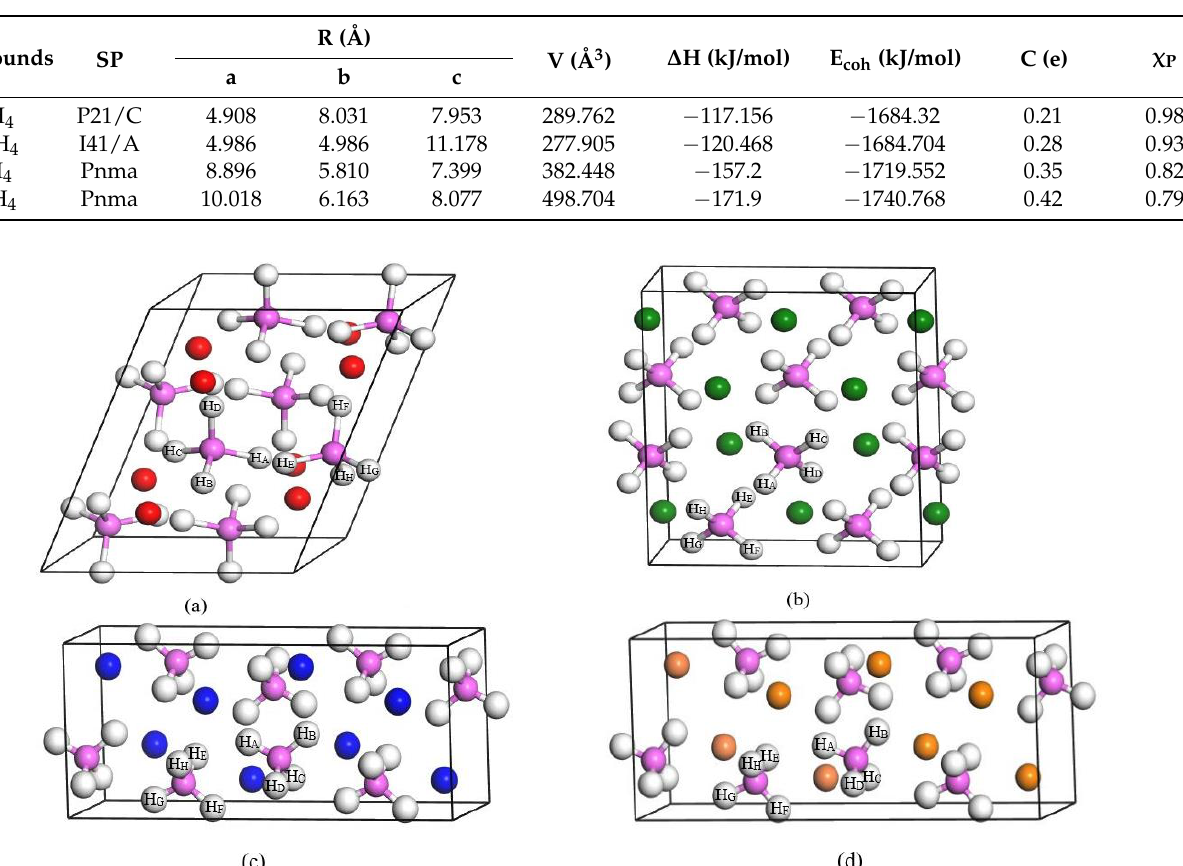
Table 1. The space group (SP), relaxed lattice parameters (R) and cell volume (V), formation enthalpy ( ∆ H), cohesive energy (E coh ), charge transfer from cation M to anion [AlH 4 ] (C), and alkali cation electronegativity ( χ P ) of MAlH 4 (M = Li, Na, K, and Cs).